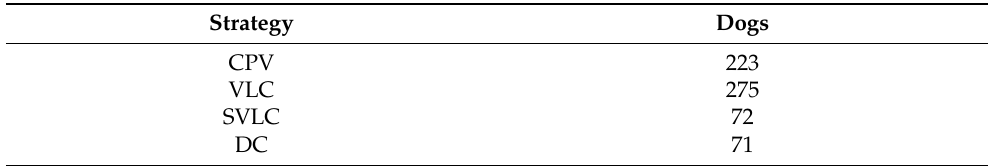
Table 2. Average number of dogs and cats vaccinated per day during the main campaign in each